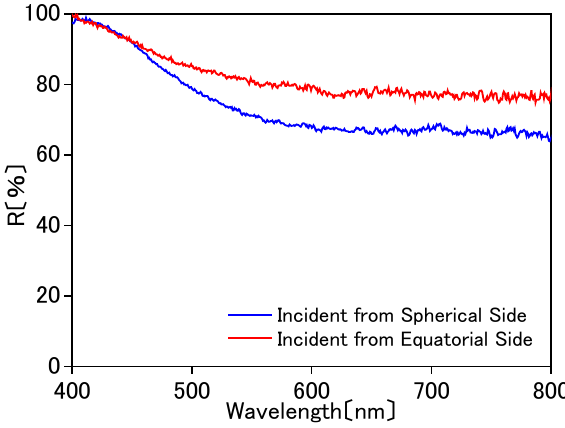
Figure 6. Relative reflectance ( R ) when the light was incident on a metal coated hemispherical particle from the spherical surface and from the equatorial plane. R reaches 80% when the light is incident on the equatorial plane.